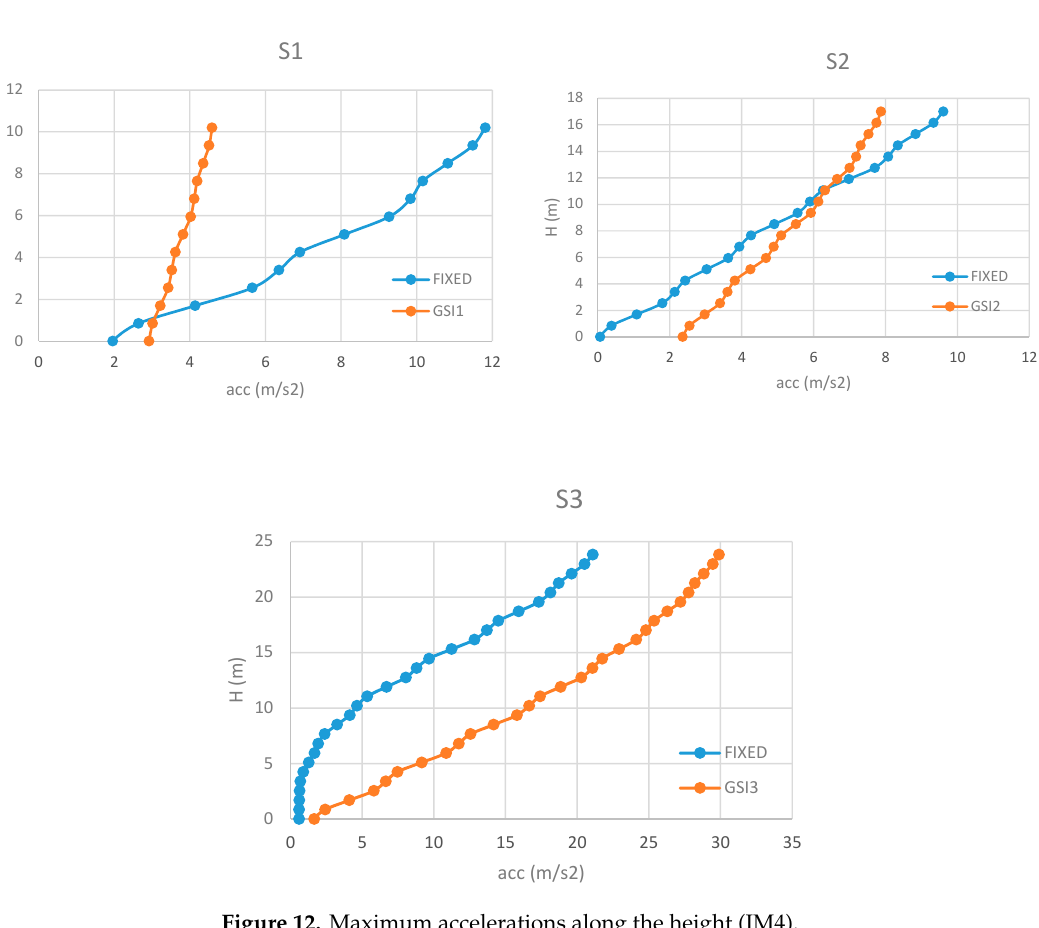
Figure 12. Maximum accelerations along the height (IM4).